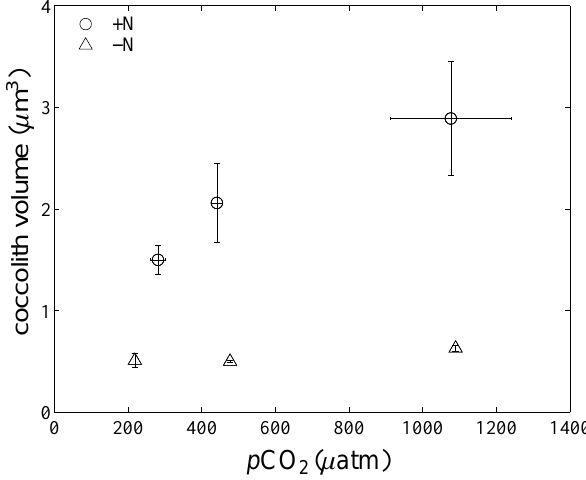
Fig. 3. Coccolith volumes under nutrient replete ( + N, circles) and nitrogen limitation ( − N, triangles) in regard to the applied p CO 2 levels.